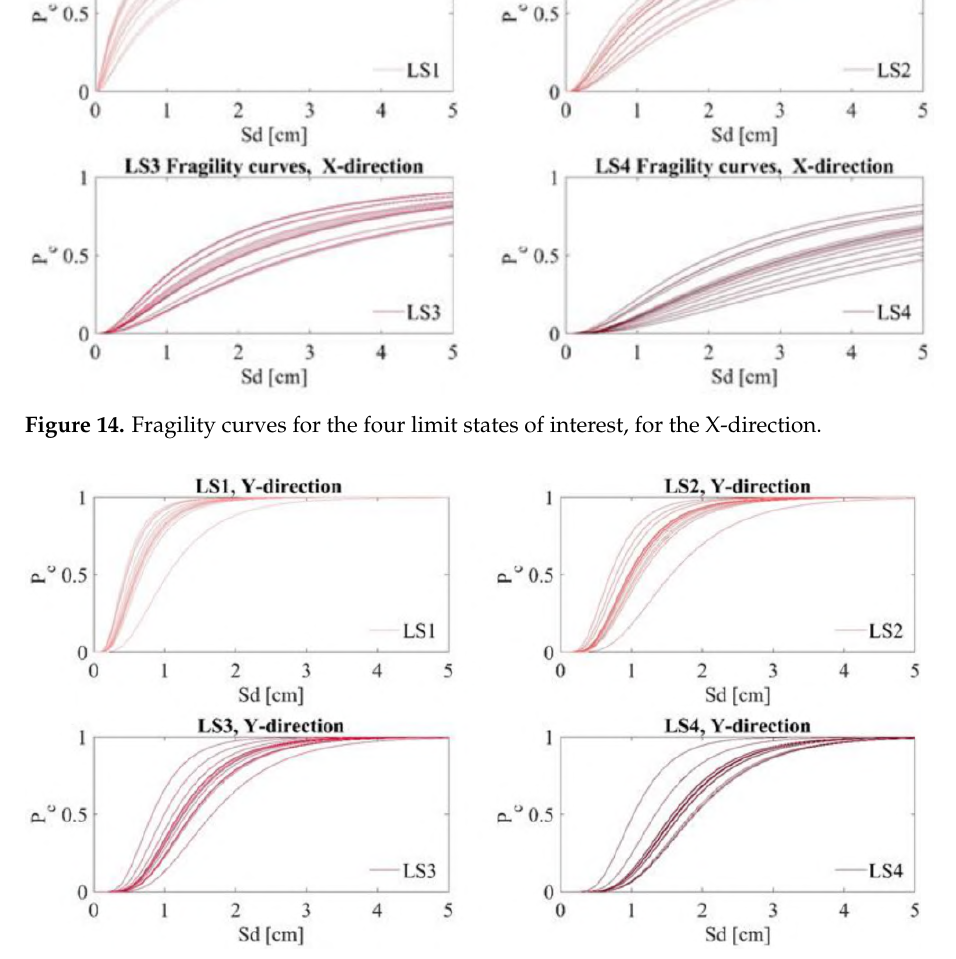
Figure 15. Fragility curves for the four limit states of interest, for the